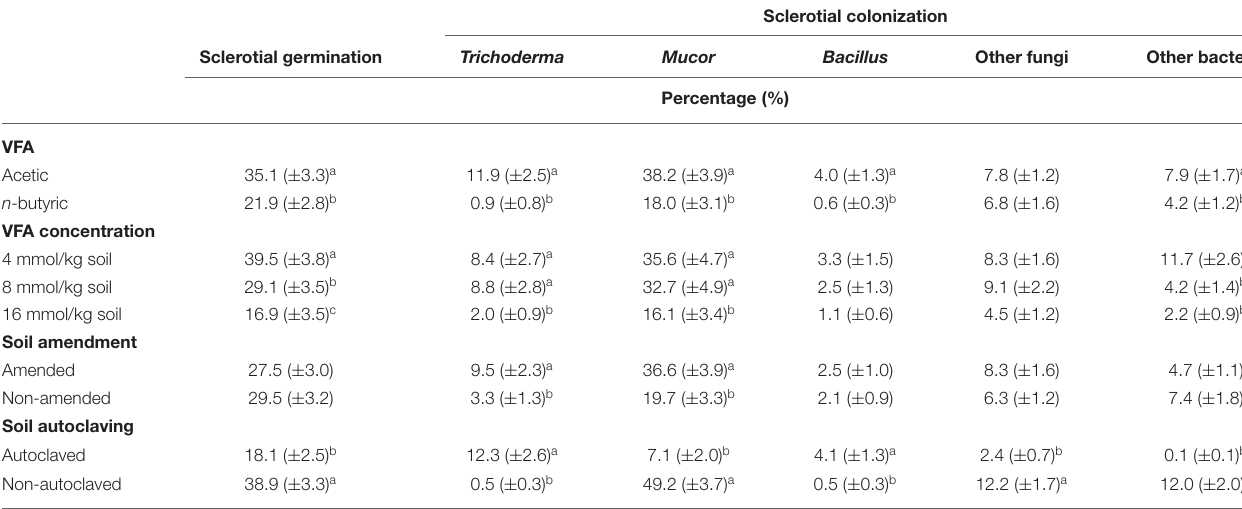
TABLE 2 | Mean percentage germination of Athelia rolfsii sclerotia and percentages colonization of sclerotia in experiment 1 as affected by main effects of volatile fatty acid (VFA) type, VFA concentration, ASD soil amendment, and soil autoclaving.